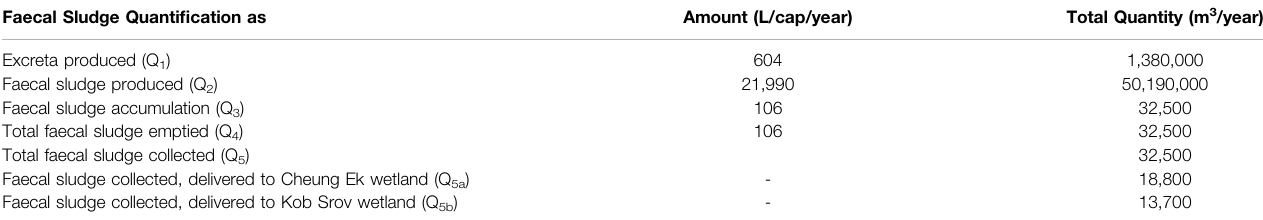
TABLE 3 | Faecal sludge quantities at different stages along the on-site sanitation service chain for households in Phnom Penh. Faecal Sludge Quanti fi cation